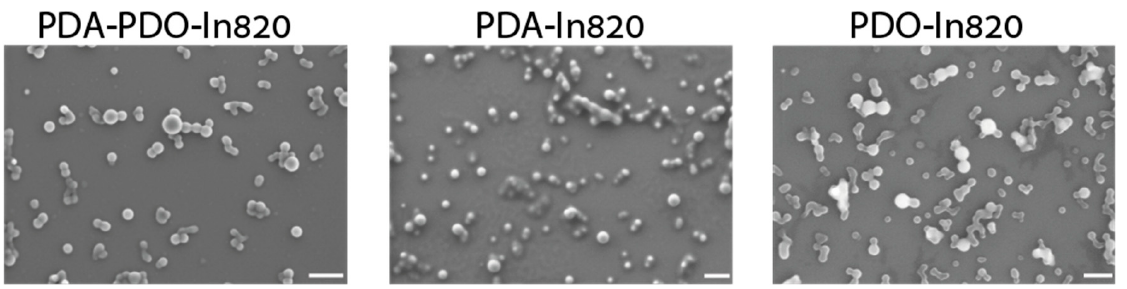
Figure 4. HR-SEM images of sorafenib nanoparticles formulated with (left to right) PDA-PDO-In820, PDA-In820, and PDO-In820, scale bars = 200 nm.